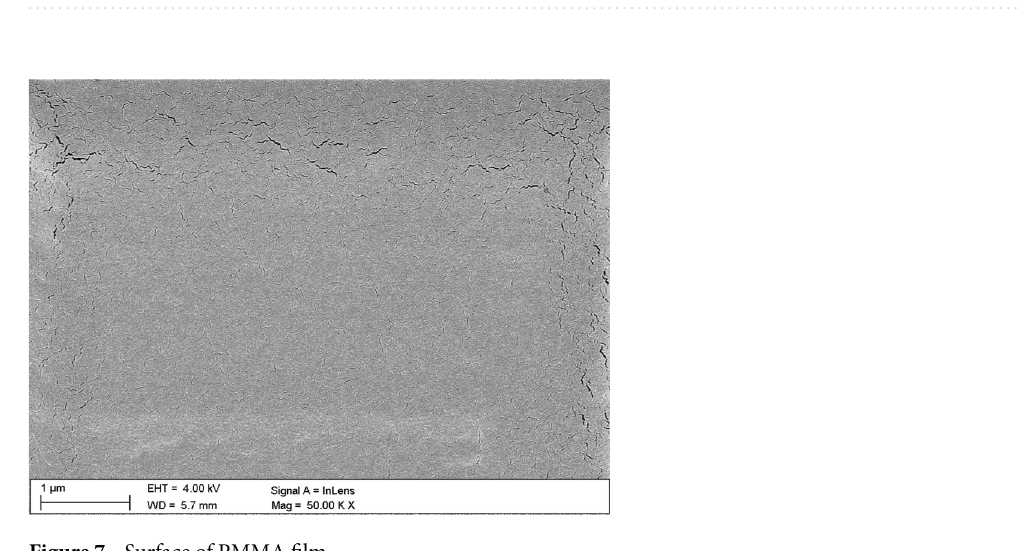
Figure 6. DSC plots, with a heating rate of 20 °C/min, for pure PMMA, and PMMA/Nb 2 O 5 (2.5, 5, 10, and 20%).